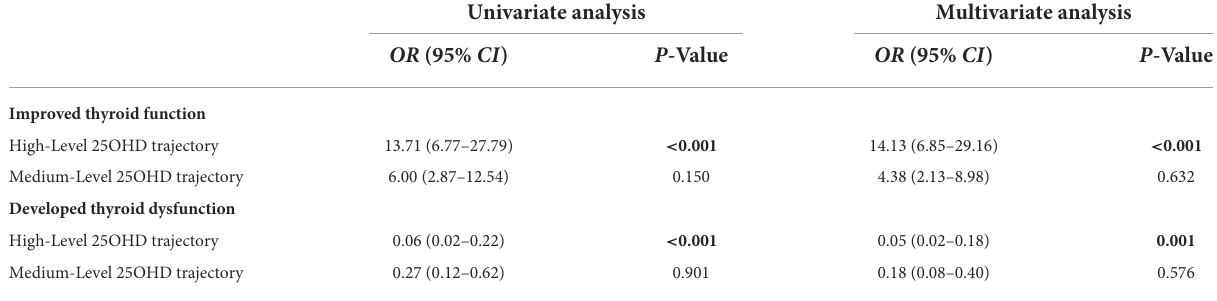
TABLE 7 Logistic regression analysis of serum 25OHD trajectory affecting postpartum thyroid